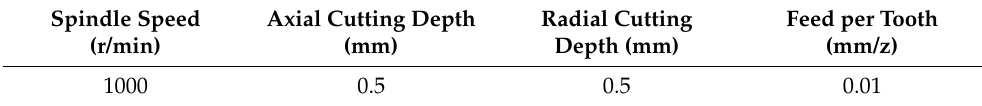
Figure 10. Experimental setup.